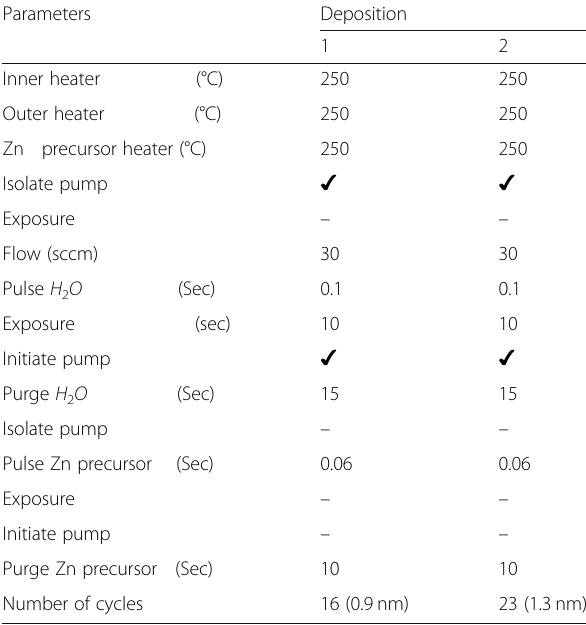
Table 1 Recipe for ALD development of ZnO nanofilms using (C 2 H 5 ) 2 Zn and H 2 O